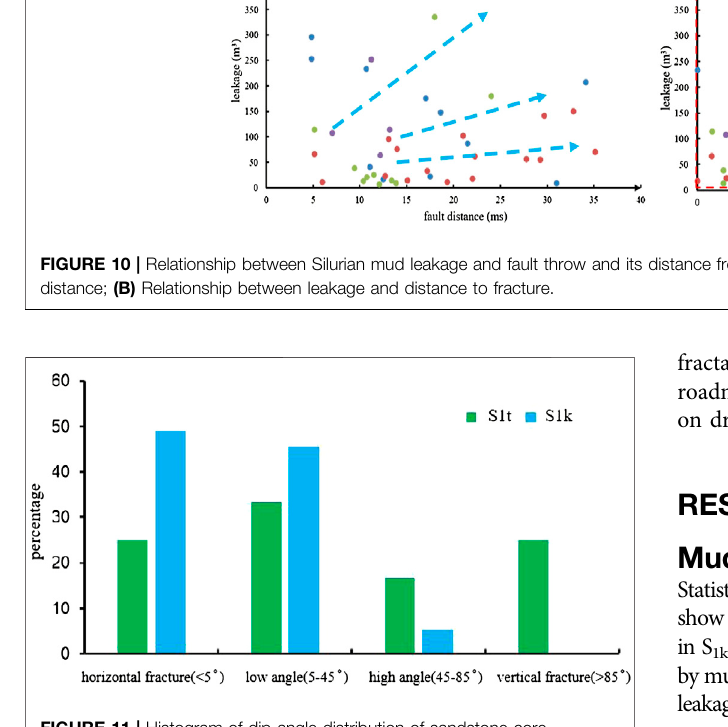
Frontiers in Earth Science |